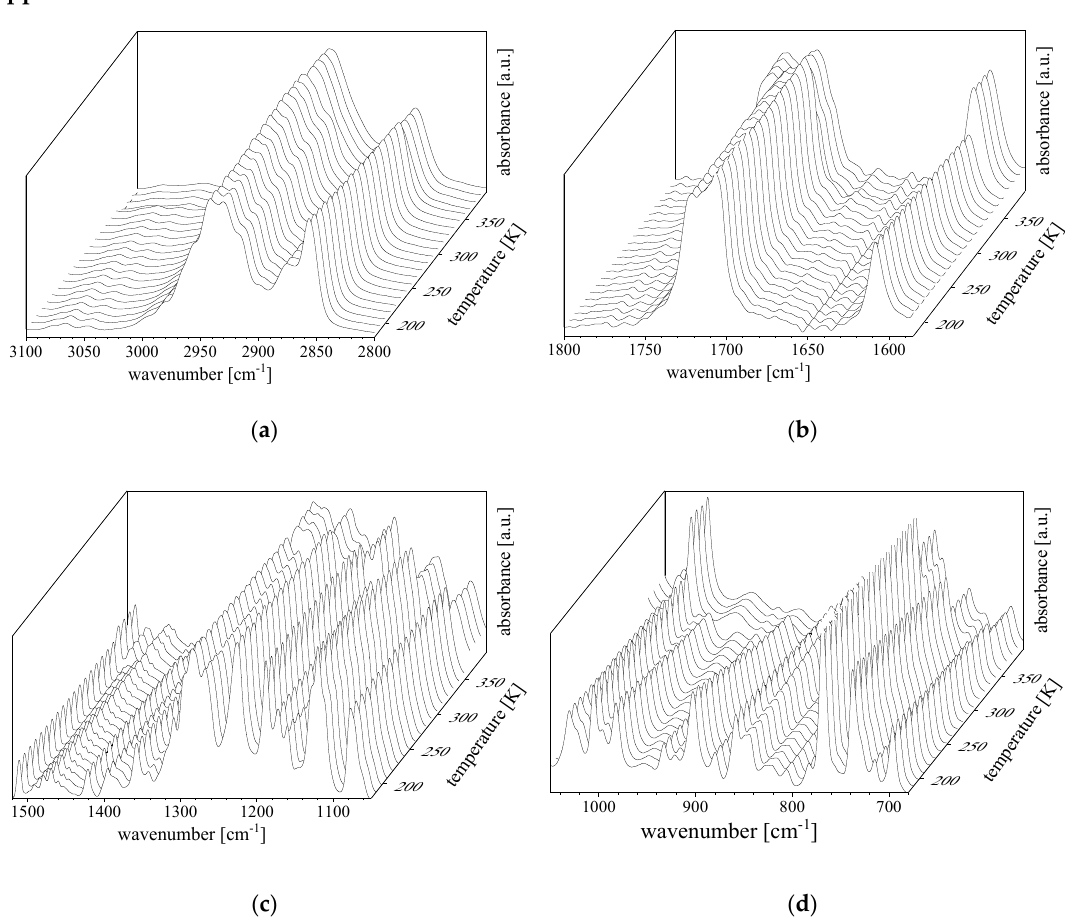
Figure A1. The FTIR spectra of 3F7HPhH7 upon heating at a rate of 2 K/min (after slow cooling) from 173 to 403 K in the wavenumber regions of: ( a ) 3100–2800 cm –1 , ( b ) 1800–1580 cm –1 , ( c ) 1520–1050 cm –1 and ( d ) 1050–680 cm –1 .